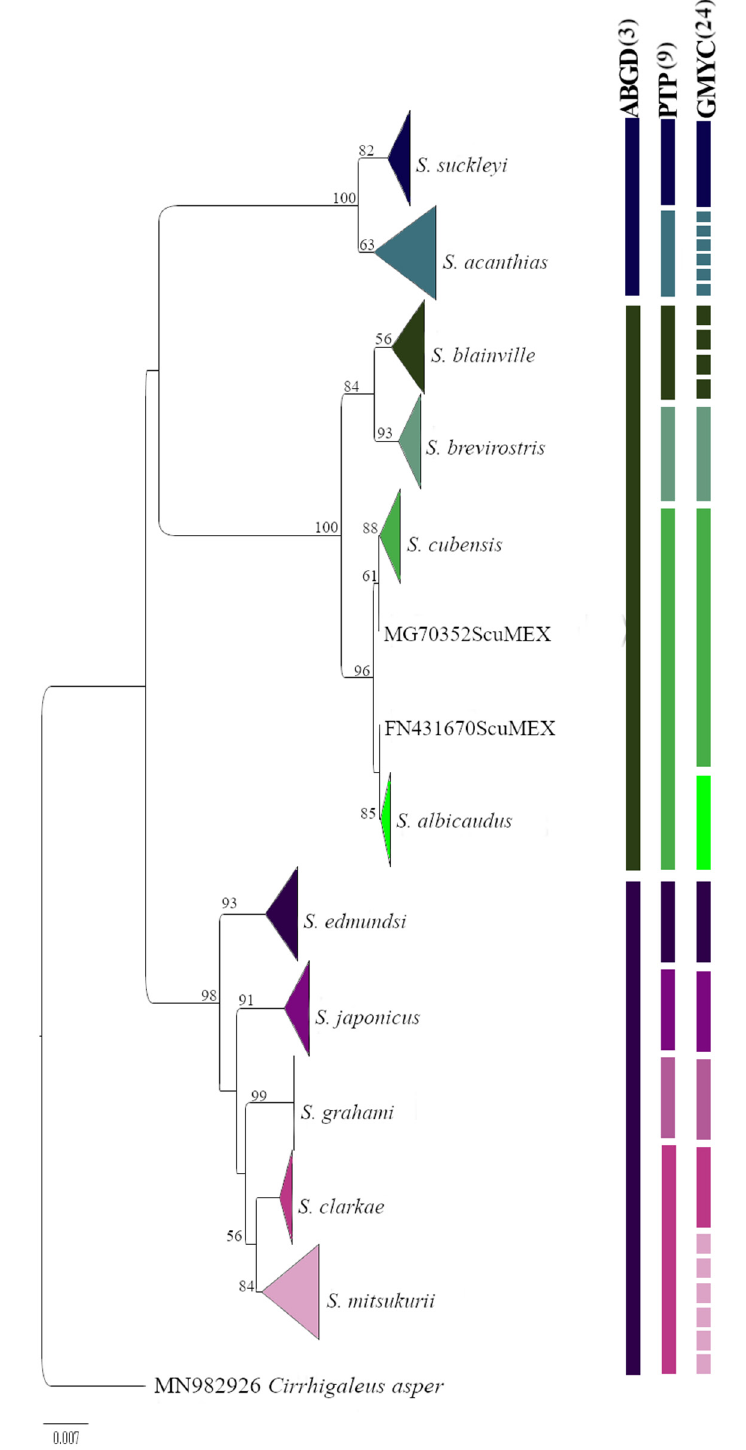
Figure 1. Neighbor-joining tree based on the COI gene from 11 nominal Squalus species with bootstrap values on branches. On the right, the vertical bars represent the division into MOTUs (molecular operational taxonomic units) obtained by ABGD (automatic barcode gap discovery for primary species delimitation), PTP (Poisson tree process), and GMYC (generalized mixed Yule coalescent) analyses.